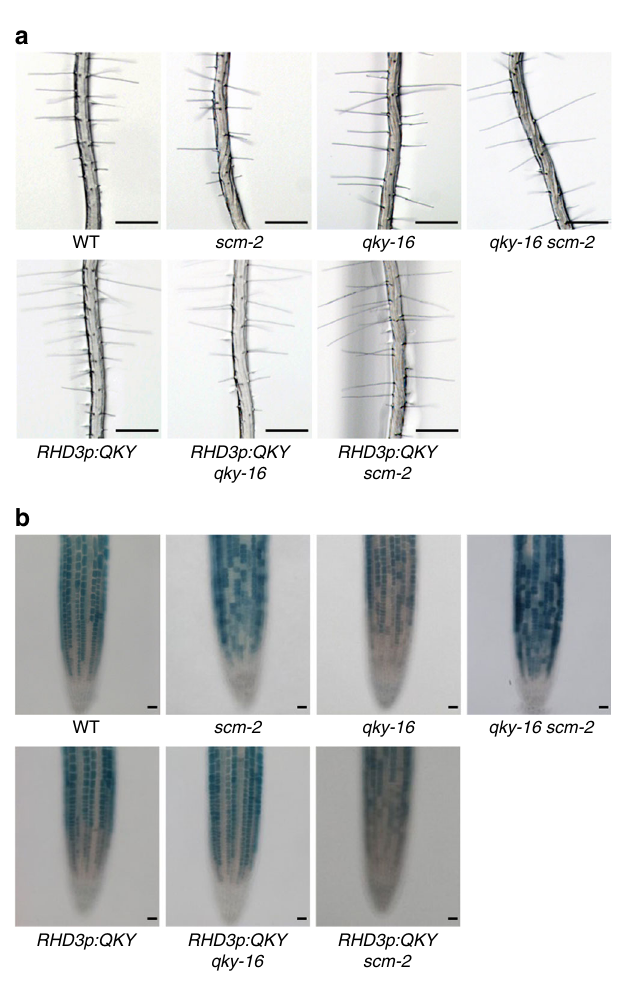
Fig. 2 QKY and SCM act in the same genetic pathway. a Root hair phenotype in the root of various mutant plants. Bar = 250 μ m. b GL2p:GUS expression pattern in the root of the corresponding various mutant